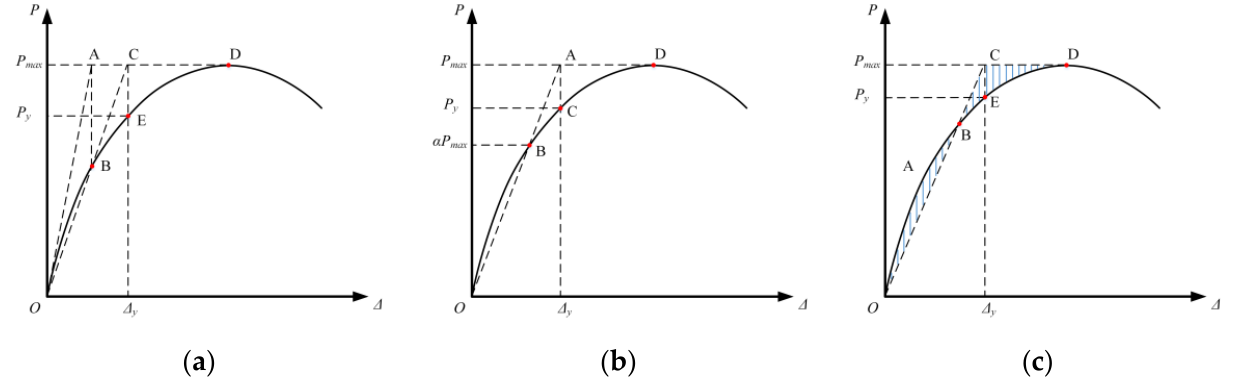
Figure 2. The yield point judgment methods: ( a ) Geometric Graphic Method; ( b ) R. Park Method; ( c ) Equivalent Elasto-Plastic Energy Method.